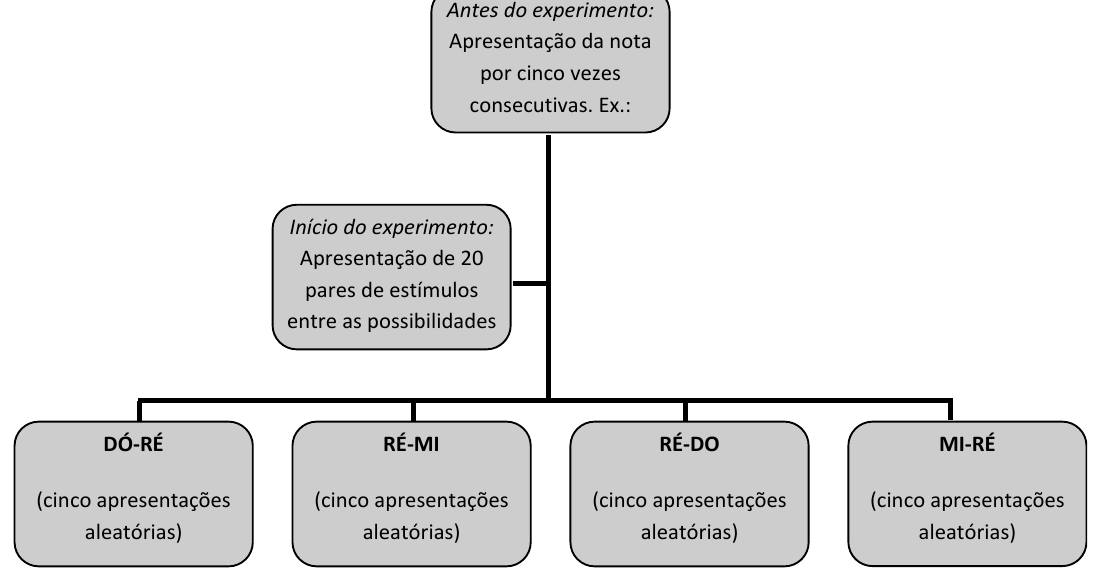
Figura 1. Procedimento de apresentação dos estímulos pelo Psysounds : exemplo em função da nota musical RÉ (ver explicação no